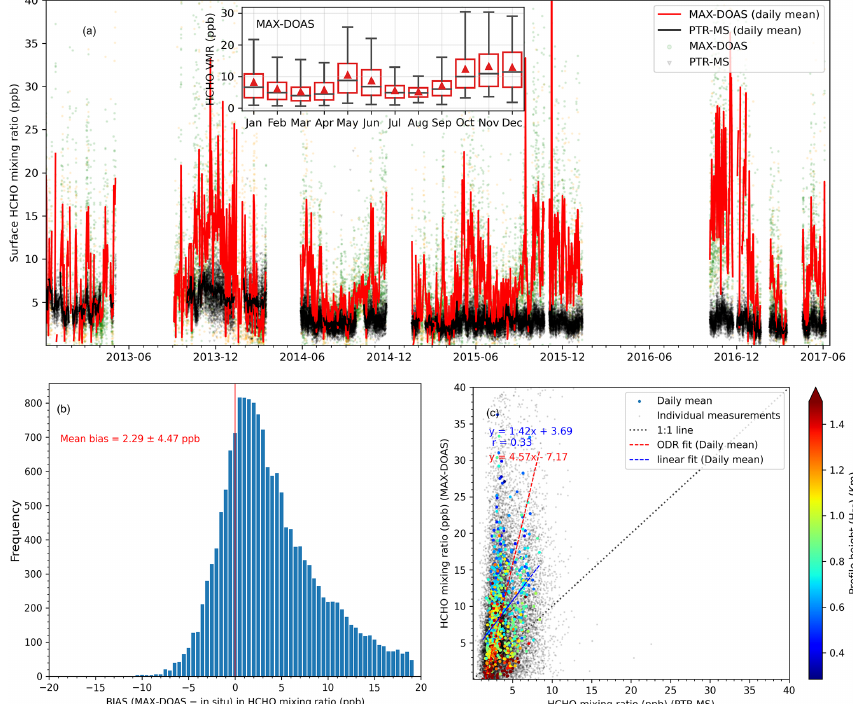
Figure 13. (a) Daily mean HCHO mixing ratios measured using an in situ chemiluminescence analyser (black line) and average mixing ratio in the lowest layer (0–200m) retrieved by the profile inversion of MAX-DOAS measurements (red line). The green and orange dots in the background show the mixing ratios corresponding to the individual MAX-DOAS elevation sequences flagged as valid and warning, respectively. The inset of (a) shows the monthly variability of the MAX-DOAS surface HCHO VMR as a box-and-whiskers plot; (b) shows the frequency distribution of the BIAS (MAX-DOAS – in situ) for the individual surface VMR measurements; (c) shows the scatter plot between the daily mean surface HCHO VMR from MAX-DOAS and PTR-MS colour-coded according to the profile height ( H 75 ). The individual measurements are shown as black dots in the background of (c)